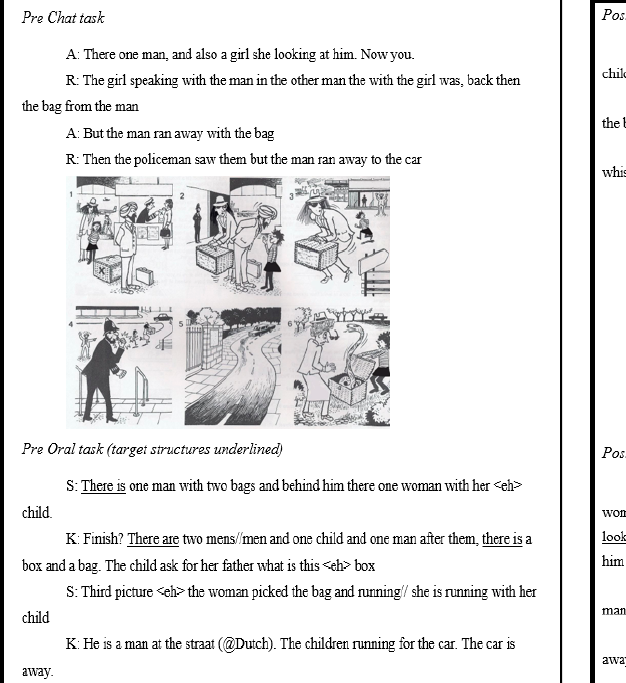
Table 2. Descriptive statistics on different linguistic measures ( N = 15).